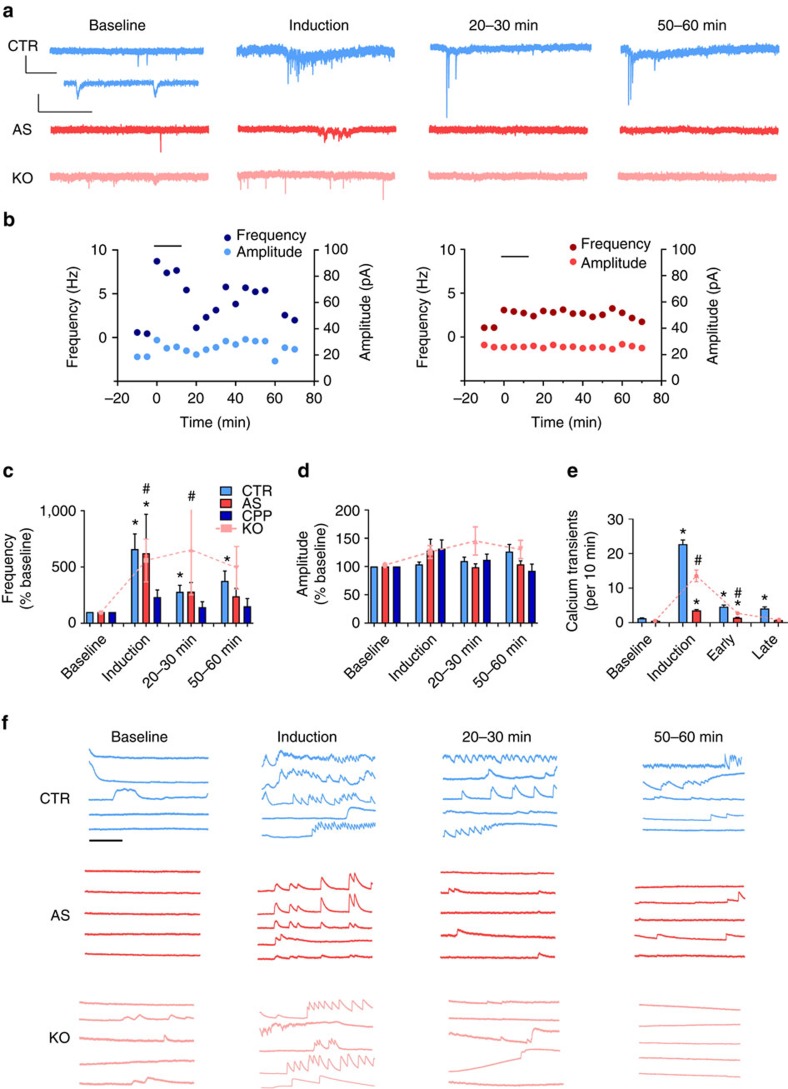
Synaptic plasticity in iPSC-derived neurons.(a) Example traces of spontaneous excitatory synaptic currents from control (CTR; top), AS (middle) and UBE3A KO (bottom) neurons at (left to right) baseline, induction, 20–30 min post induction, and 50–60 min postinduction (see Methods for details). Scale bar for top CTR, AS and UBE3A KO, 20 pA, 1 s. Scale bar for bottom CTR trace, 10 pA, 200 ms. (b) Example time courses for frequency and amplitude of spontaneous synaptic currents from an individual neuron from (left) a CTR subject and (right) an AS patient. Plasticity induction period indicated by black bar. (c) Individual data for CTR and AS-derived neurons (12–25 weeks in culture) showing frequency of spontaneous synaptic currents during plasticity induction and 20–30 and 50–60 min post induction. *P<0.05, indicates difference for CTR or AS; #for UBE3A KO (Student's t-test). (c,d) Group data for CTR (n=30), AS-derived (n=20) UBE3A KO (n=9) and +CPP (n=8) neurons showing (c) mean frequency and (d) mean amplitude of spontaneous synaptic currents during plasticity induction and 20–30 and 50–60 min post induction. (e) Quantification of frequency of calcium transients from CTR, AS and UBE3A KO lines pictured in f (n>240 for CTR and AS; n>80 for UBE3A KO). *P<0.05, indicates difference for CTR or AS; #for UBE3A KO (Student's t-test). Early: 20–30 min post induction; late: 45+ min post induction. (f) Example traces of calcium imaging during same protocol as above from (top) CTR, (middle) AS and (bottom) UBE3A KO cultures. Scale bar, 3 min. Error bars represent mean ±s.e.m.